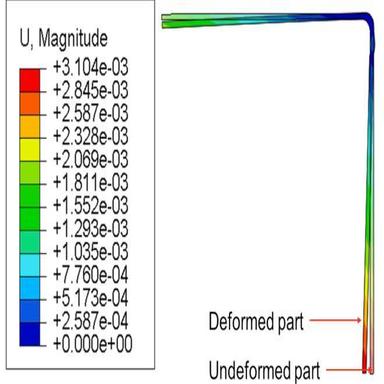
RS-36-1 L-shape laminate before (undeformed) and after cure (deformed). The units of the displacement U are in meters. (For interpretation of the references to colour in this figure legend, the reader is referred to the web version of this article.)